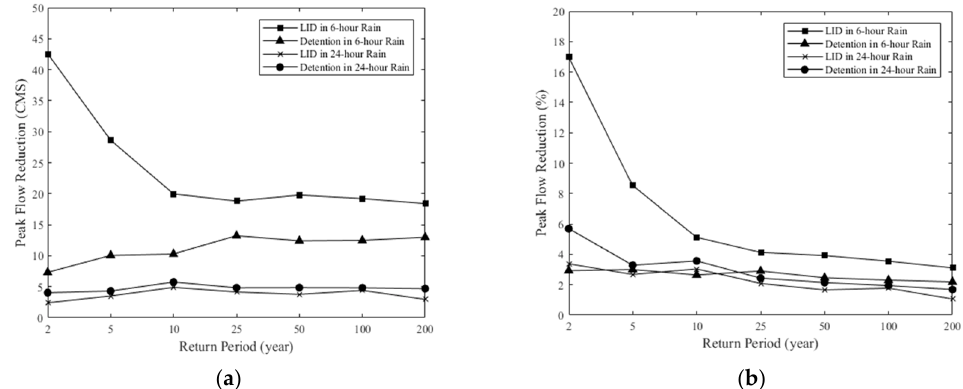
Figure 4. The flood peak reduction by LIDs and detention ponds for different rainfall durations and return periods: ( a ) quantify of the peak flow reduction; ( b ) percentage of the peak flow